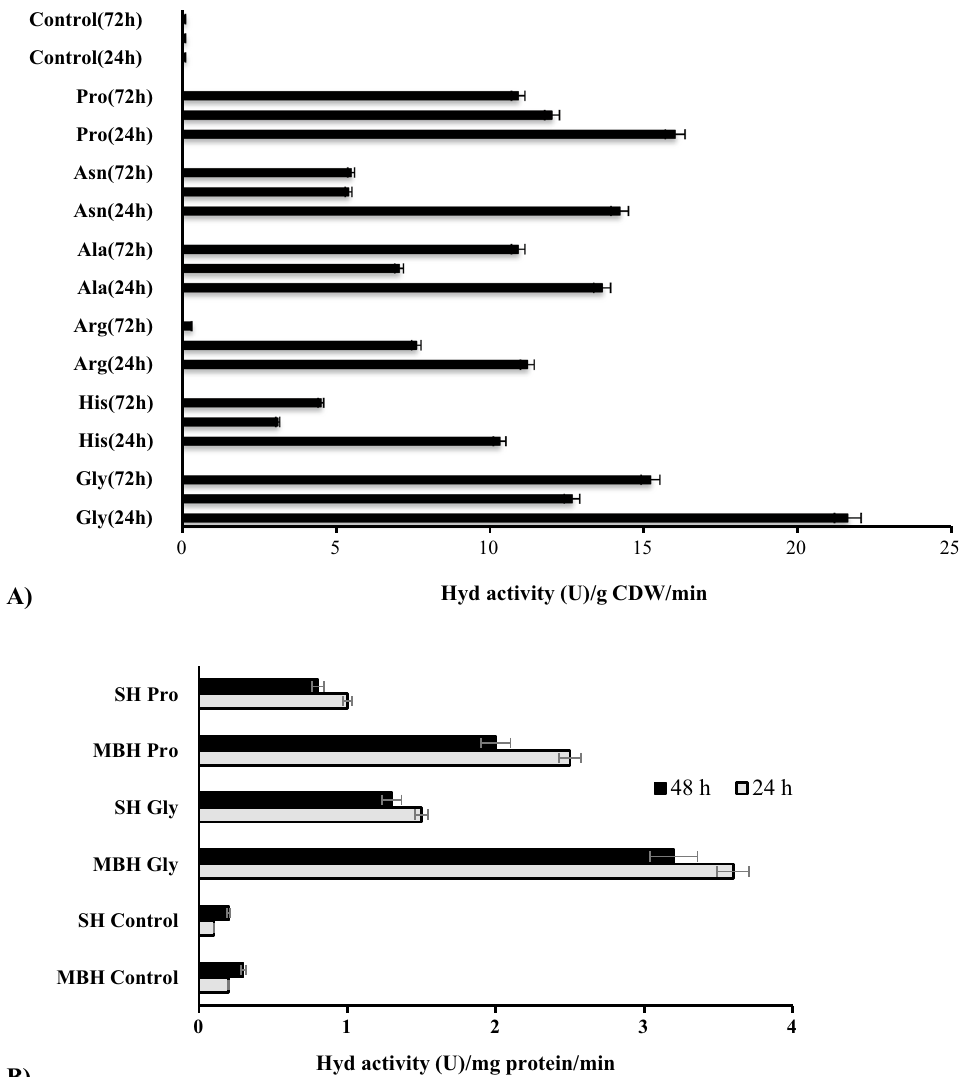
Fig. 3 H 2 -oxidizing total Hyd activity of whole cells ( A ) and SH and MBH activities ( B ) of R. eutropha H16 under influence of L-AAs. L-AAs (Gly, Ala, Asn, Pro, Arg, His) were added in FN medium at 7.0 μmol/ml concentration. CDW is Cell Dry Weight. Gly- Glycine, Ala- Alanine, Asn- Asparagine, Pro- Proline, Asp-asparagine acid, Tyr -tyrosine, Cys -cysteine, Ser -serine, Glu -glutamic acid, Arg -Arginine, His -Histidine and B1-Thiamine, B3-Nicotinic acid, B6-Pyridoxine. SH and MBH activities were determined in Pro- and Gly—supplemented samples. For the other details, see Materials and methods and the legends in Fig. 3 (72 h, n 5, p < =